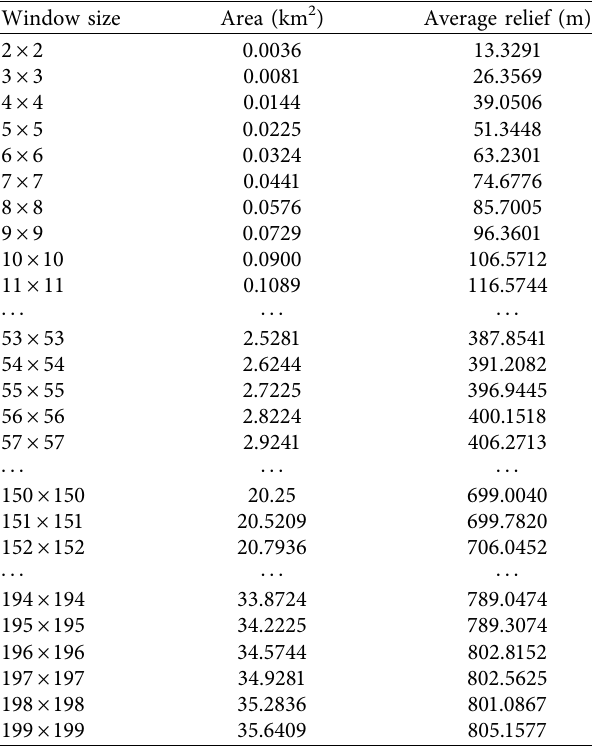
Table 3: The relation between the size of the window and the average topographic